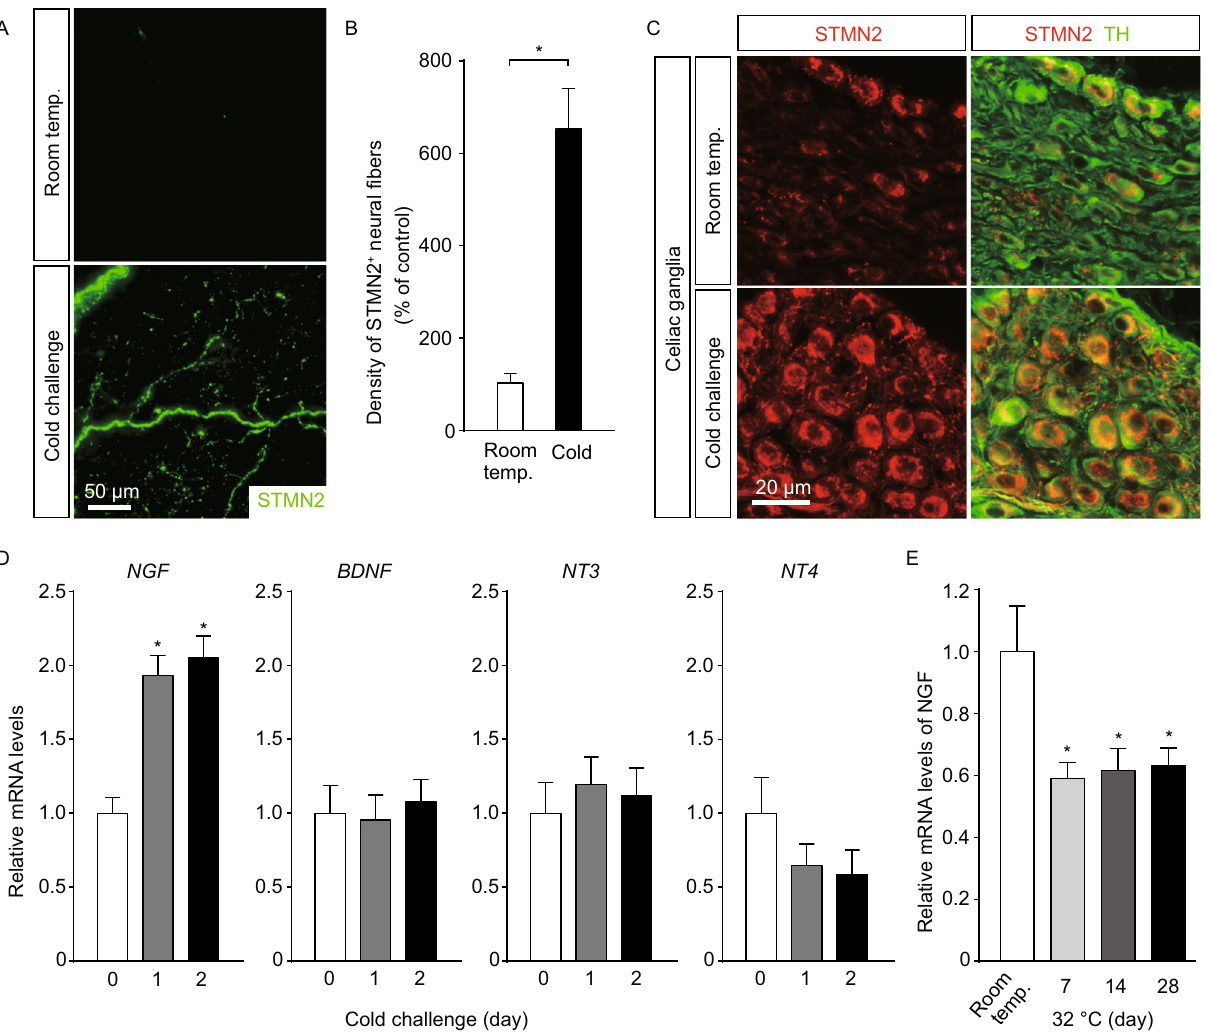
Figure 3. Cold-elicited NGF expression for intra-adipose sympathetic plasticity. (A – D) The wildtype mice were subject to cold challenge. (A and B) iWATwas processed for the whole-mount immunolabeling of STMN2. (A) Representative 3D projections of iWAT imaged at 12.6× magni fi cation on the lightsheet microscope. (B) Density of the STMN2-positive neural fi bers was quanti fi ed. n = 4, mean ± SEM, * P < 0.01. (C) STMN2 expression in sympathetic neurons of the celiac ganglia was examined by conventional immunostaining. (D) Expression levels of the neurotrophin genes in iWAT were determined by the qPCR analysis. n = 4, mean ± SEM, * P < 0.01. (E) The wildtype mice were subject to thermal-neutral condition (32 °C), and expression levels of NGF in iWAT were determined by the qPCR analysis. n = 4, mean ± SEM, * P <